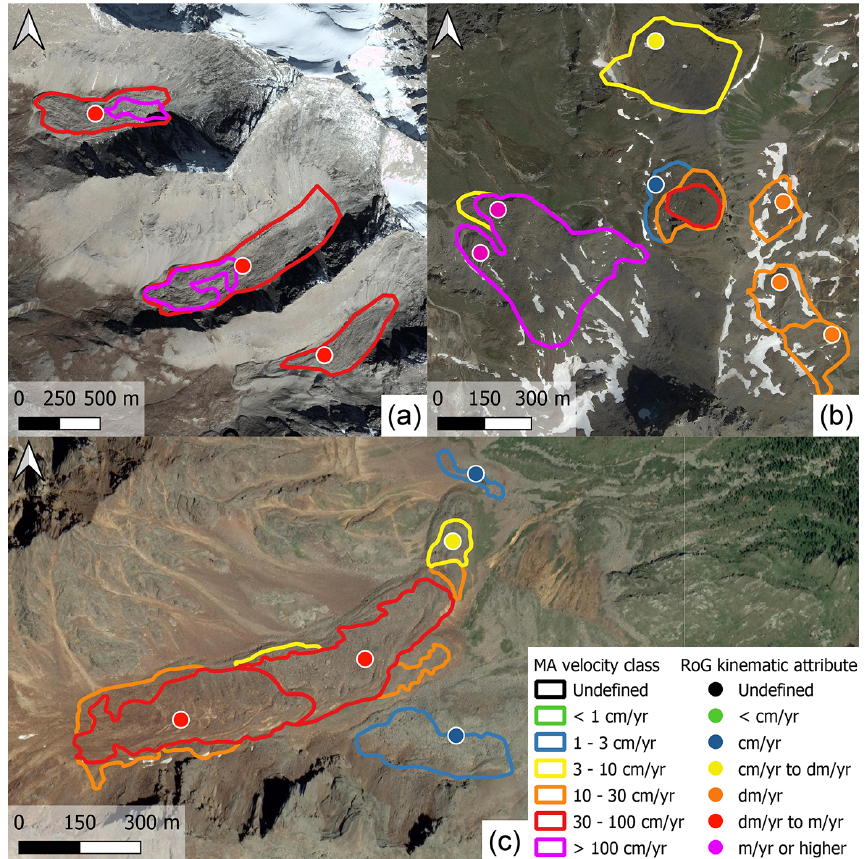
Figure 4. Examples of MAs and RoG kinematic attributes produced for Vanoise ( a , location: 45 ◦ 16 (cid:48) 10 (cid:48)(cid:48) N, 7 ◦ 03 (cid:48) 00 (cid:48)(cid:48) E, 2900m), the west- ern Swiss Alps ( b , location: 46 ◦ 10 (cid:48) 25 (cid:48)(cid:48) N, 7 ◦ 30 (cid:48) 45 (cid:48)(cid:48) E, 2700m) and southern Venosta ( c , location: 46 ◦ 28 (cid:48) 20 (cid:48)(cid:48) N, 10 ◦ 48 (cid:48) 00 (cid:48)(cid:48) E, 2500m). Orthoimages from © Google Earth